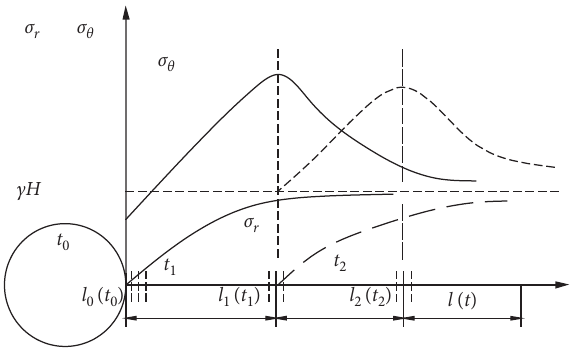
Figure 2: Analysis of zonal disintegration